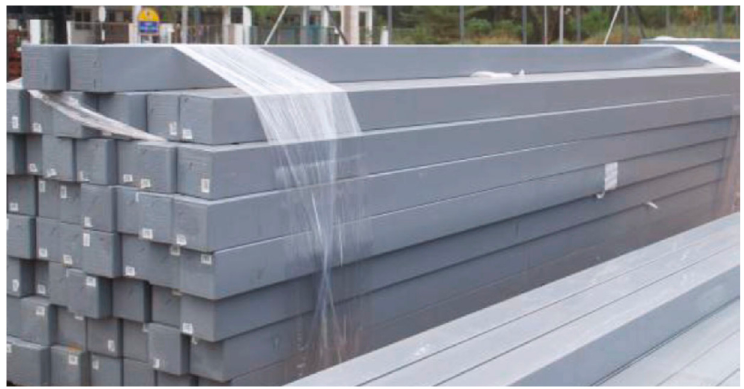
Figure 2. Cross-arm beams in stockpiles after pultrusion for distribution [57].